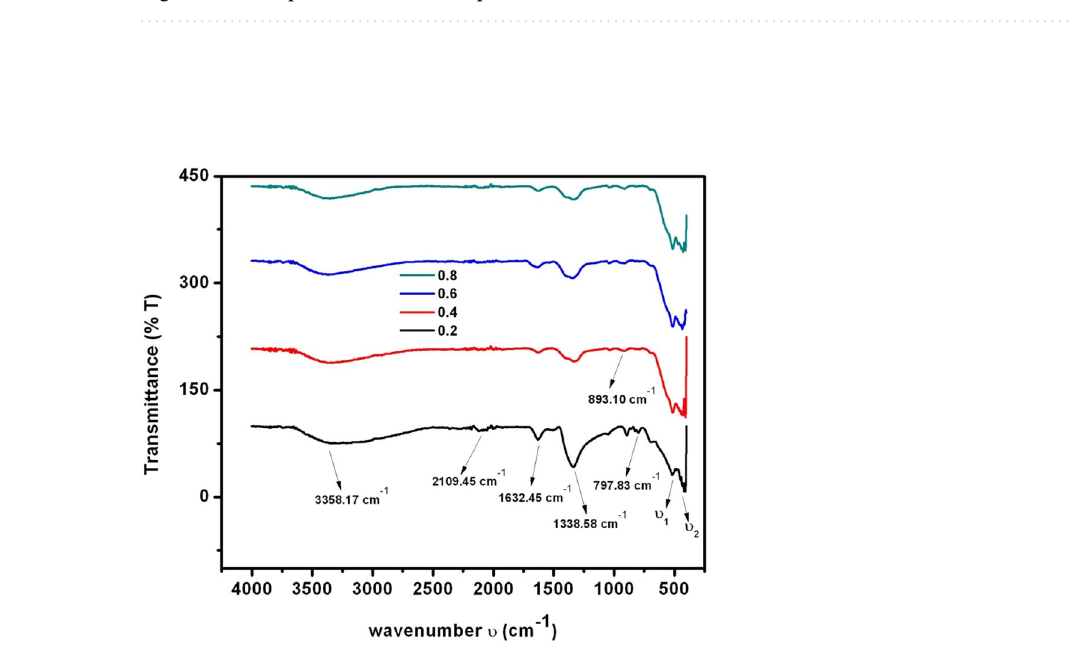
Figure 6. FTIR spectra of SLFO